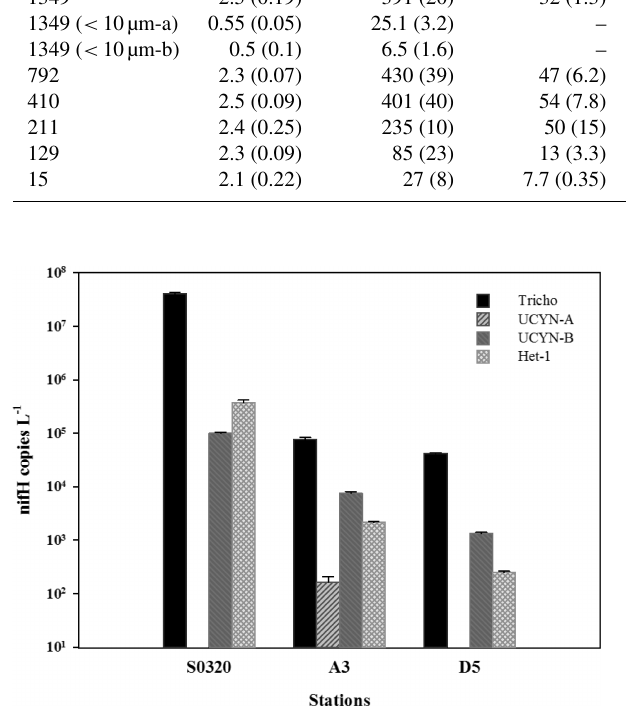
Figure 2. Cyanobacteria diazotroph nif H phylotype abundances ( nif H gene copiesL − 1 ) . Tricho: Trichodesmium spp.; UCYN: uni- cellular N 2 -fixing cyanobacteria from Group A, B; Het-1: hetero- cystous cyanobacteria from Group 1. Error bars represent the stan- dard deviation for triplicate natural